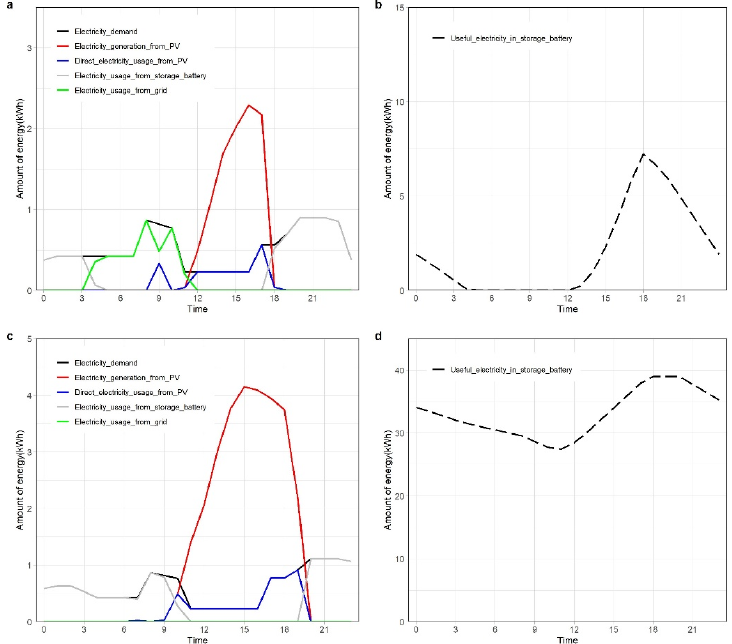
Figure 16. Energy performance of renewable energy system on specific dates in spring and summer for the newly constructed passive house ( a ) and ( b ): data in 1/12; ( c ) and ( d ): data in 8/16.